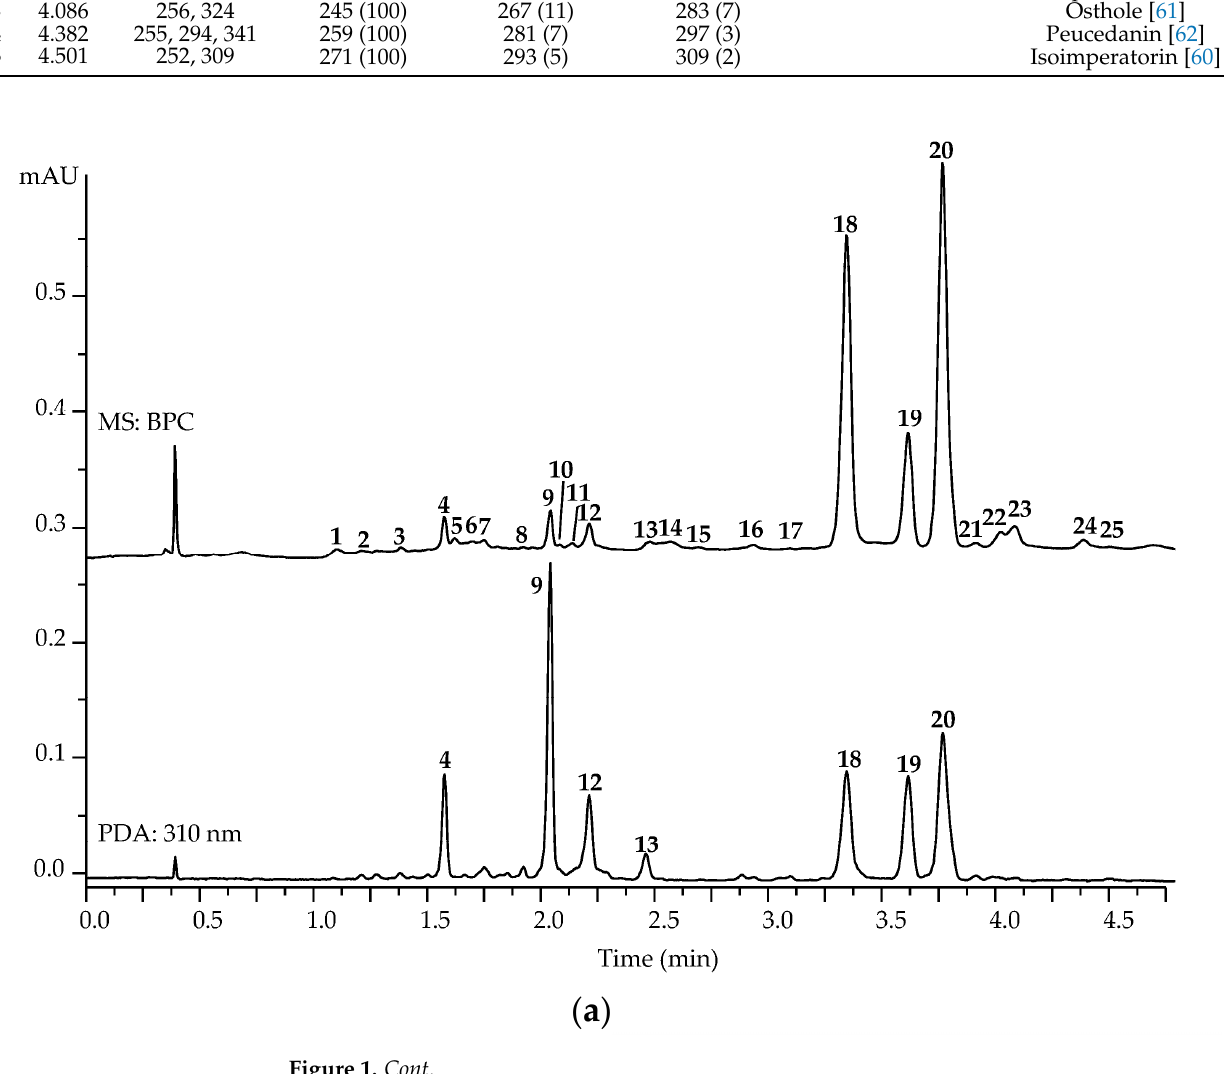
( e ) Figure 1. ( a ) High-performance liquid chromatography with electrospray ionization triple quadru- pole mass spectrometric detection chromatogram (base peak intensity chromatogram, positive ion- ization; MS: TIC) and photodiode array detection at 310 nm (PDA: 310 nm) chromatograms of an extract of L. officinale fresh roots (cv. Lider). ( b ) UV and mass spectra of principal coumarins: apterin ( b ), xanthotoxin ( c ), isopimpinellin ( d ), and pimpinellin ( e ). Compounds are numbered as listed in Table 2.